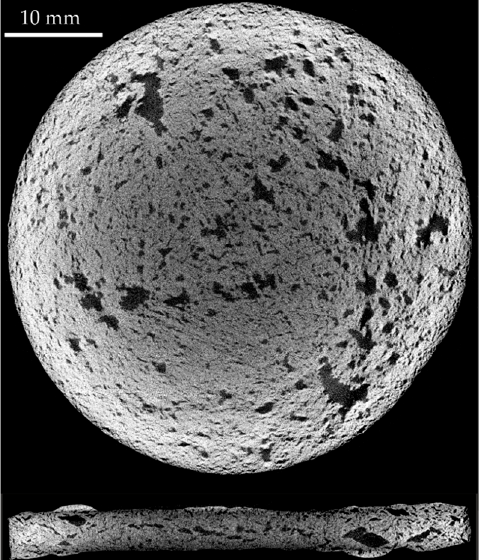
Figure 9. XRM sectional images of sample no. 1 (sample category I): foaming temperature, 550 °C; foaming time, 1 min; 0.2 wt.% TiH 2. foaming time, 1 min; 0.2 wt.% TiH 2